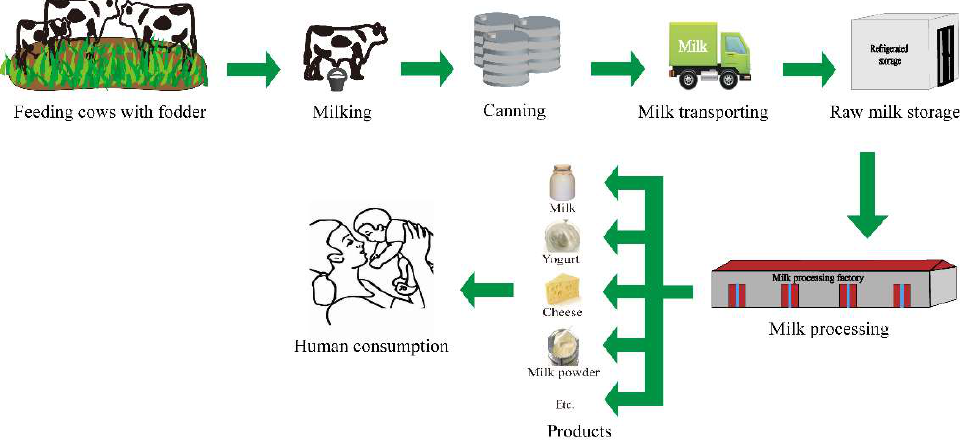
Figure 3. Sources of BPA in milk and dairy products.